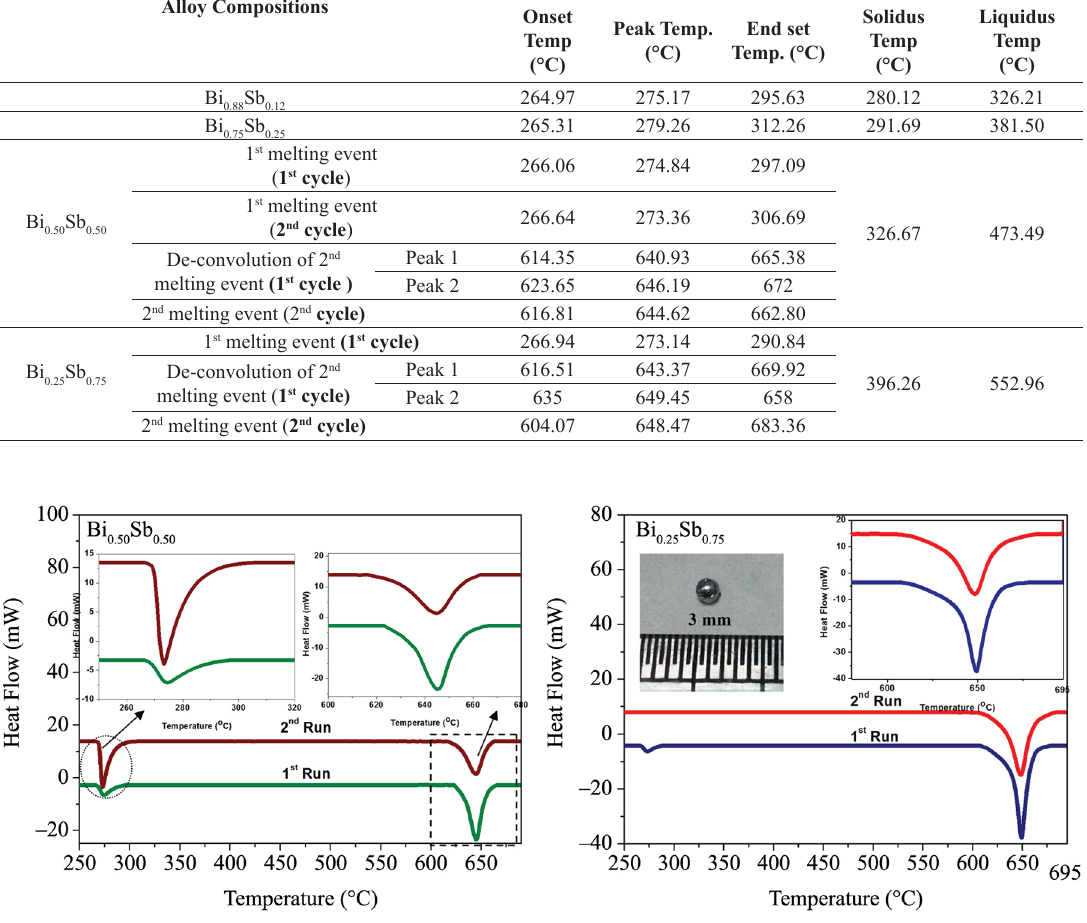
Sb , and (b) Bi Sb alloys prepared at 140 °C for 12h with MR of 0.50 0.50 0.25 0.75